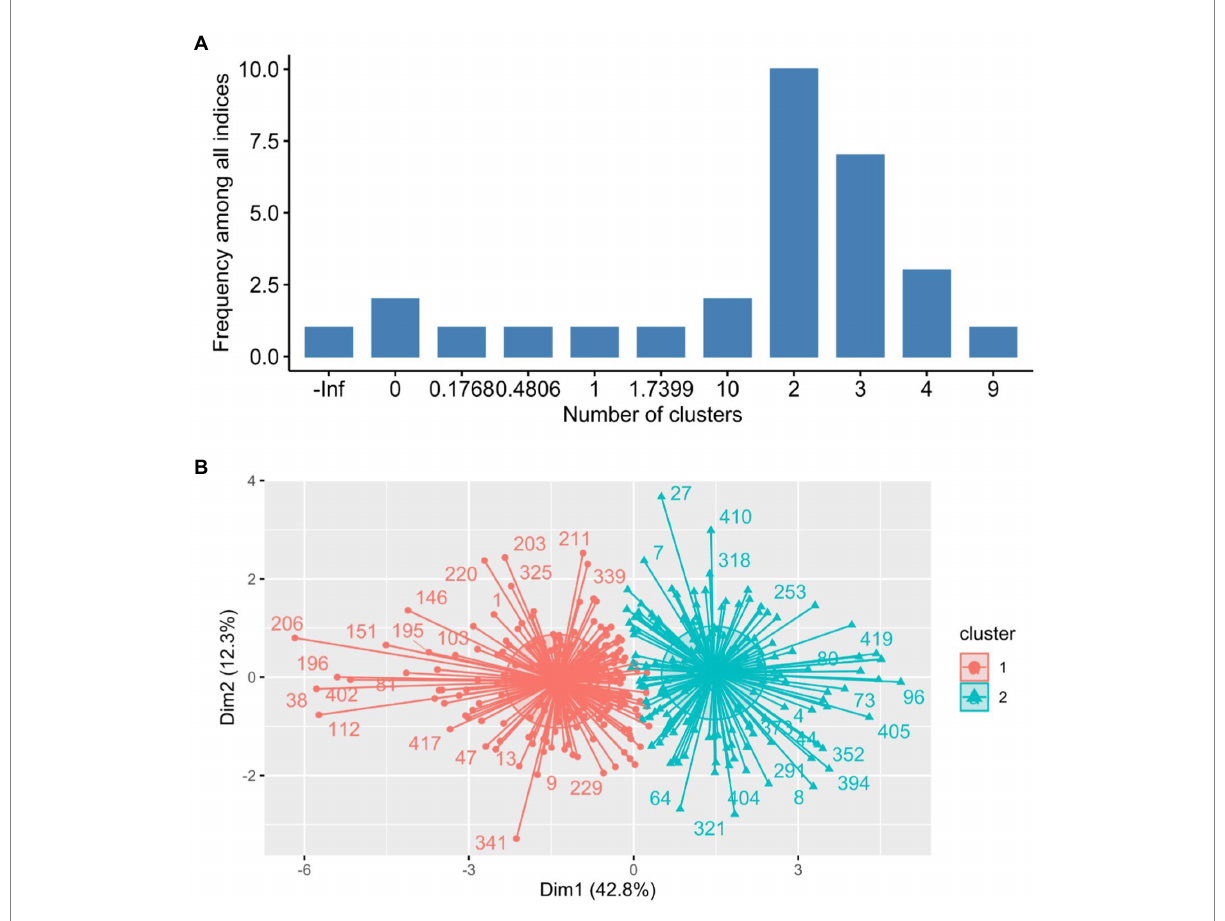
FIGURE 3 (A) Number of clusters to classify students according to stressors. (B) Cluster plot depicting the two groups (low and high stress).